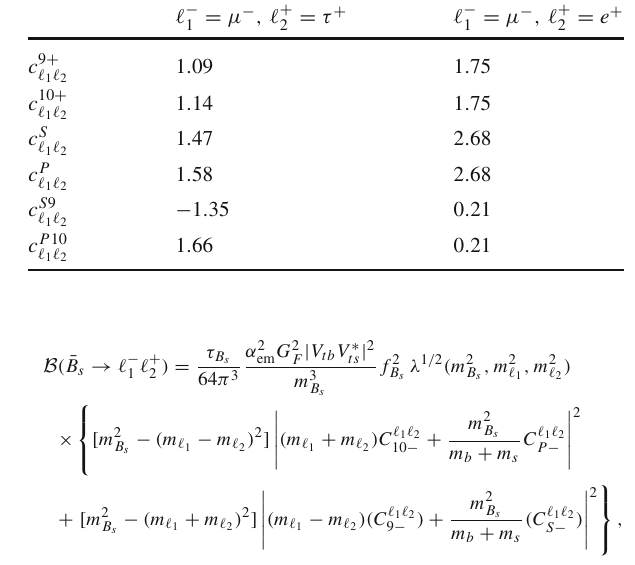
Table 3 Experimental upper limits for LFV B decays at 90% CL Observable